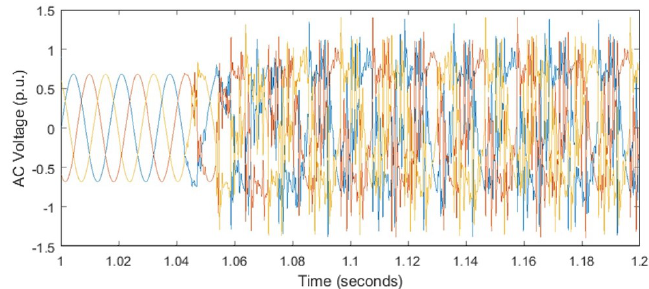
Figure 12. Simulation results with rectifier